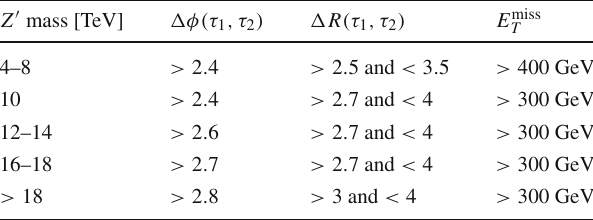
Table 5 List of mass dependent cuts optimised to maximise the sensi- tivity for the Z (cid:2) → ττ